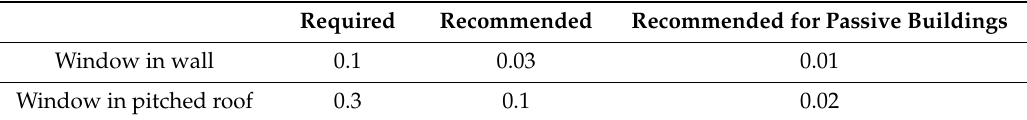
Table 1. Standard values of linear thermal transmittance, 𝜓 𝑤 (W/(m·K)), as a result of thermal couplings. Adapted from the Czech national standard [18].